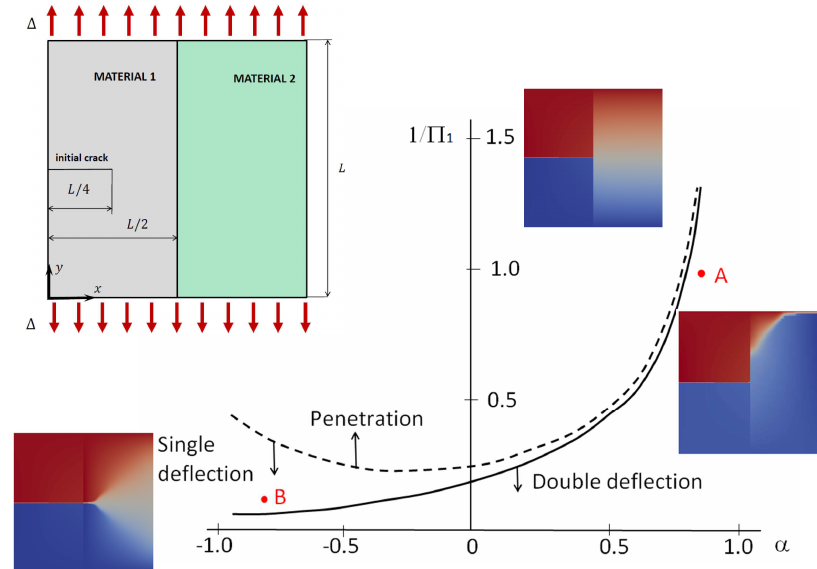
Figure 11. Geometry and boundary conditions for the bi-material problem. Crack pattern scenarios for brittle interface. The contour plots of the dimensionless vertical displacement field correspond to three different cases labeled A (double deflection), B (single deflection), C